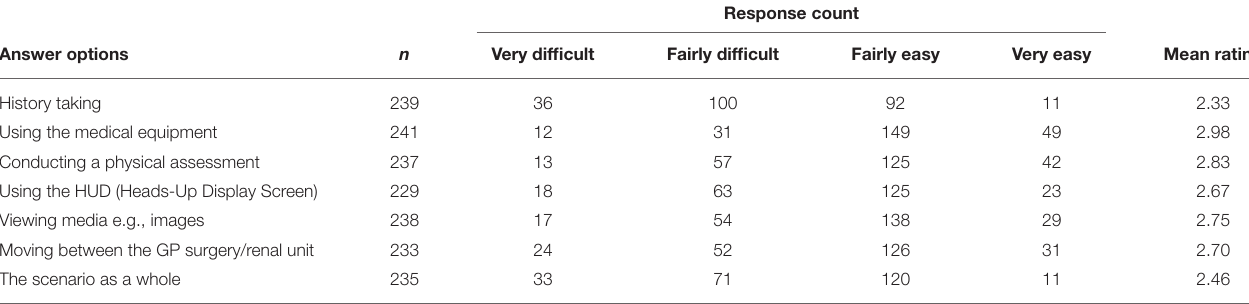
TABLE 2 | Ease of use of the features during the use of virtual world.